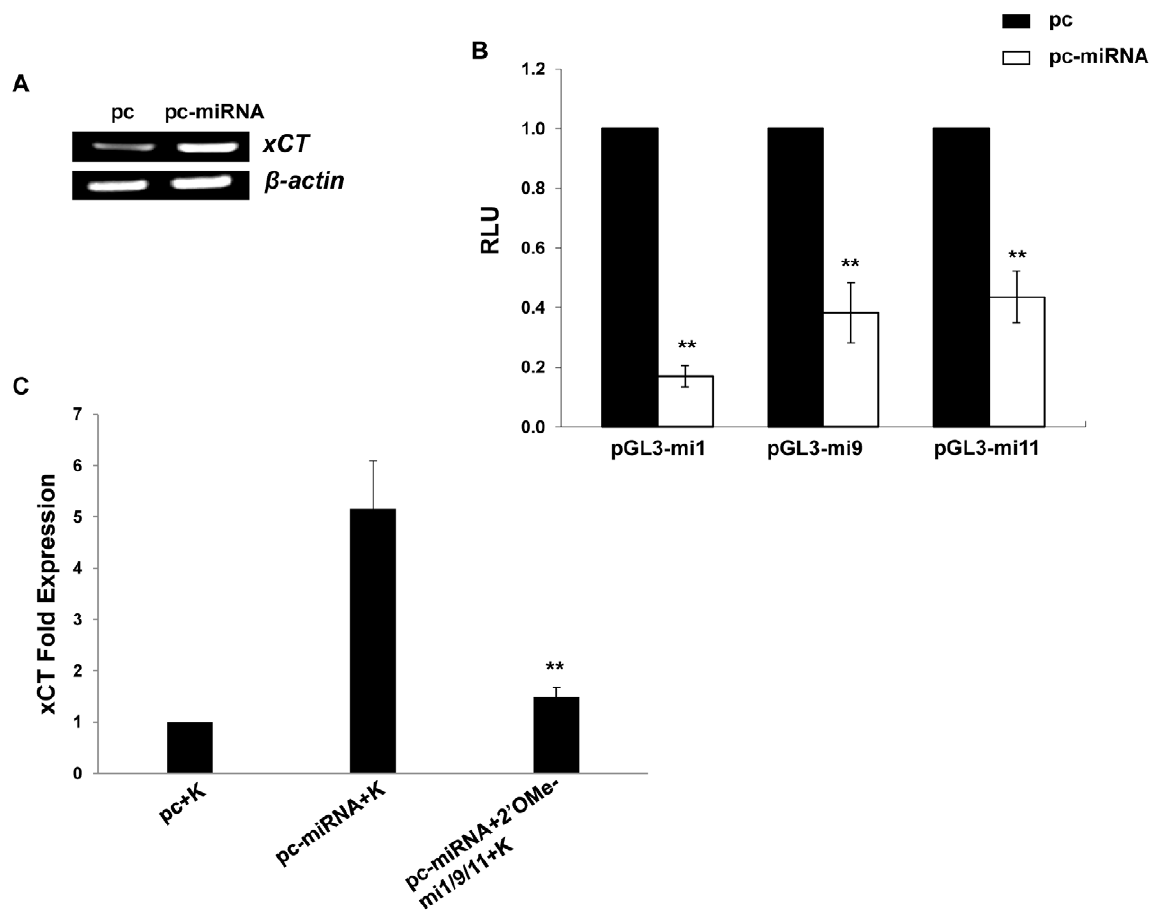
Figure 2. KSHV miRNAs upregulate xCT expression by macrophages. ( A ) RT-PCR was used to determine expression of xCT transcripts in RAW cells transfected with either control (pc) or miRNA-expressing vectors (pc-miRNA). b -actin was used as a loading control. ( B ) RAW cells were co- transfected with miRNA luciferase reporter constructs (pGL3-miX where X=complimentary sequence for the individual KSHV miRNAs noted) and either control or miRNA-expressing vectors. 48 h later, luciferase expression was determined for miRNA transfectants relative to controls (RLU). ( C ) Cells were transfected with control or miRNA-expressing vectors with or without 2’OMe RNA antagomirs targeting miR-K12-1, miR-K12-9, and miR- K12-11 (mi1/9/11). 48 h following subsequent incubation with KSHV (K), qRT-PCR was used to determine relative xCT transcript expression. For all assays, error bars represent the S.E.M. for three independent experiments. * *=p , 0.01.